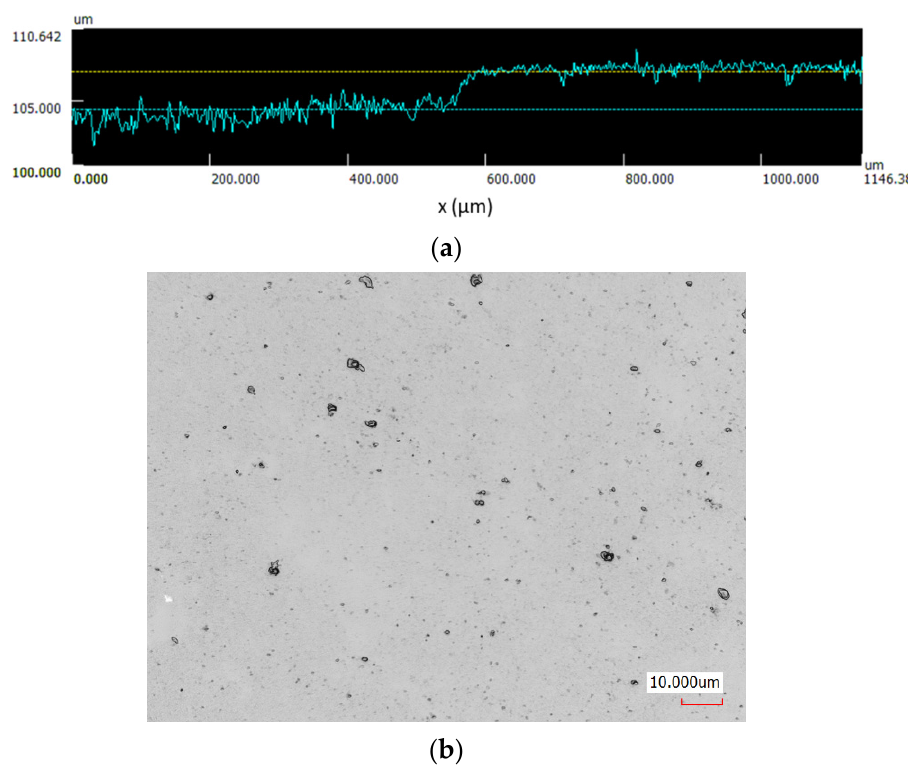
Figure 1. An example of the film thickness measurement ( a ) and surface quality ( b ) after the deposition process.